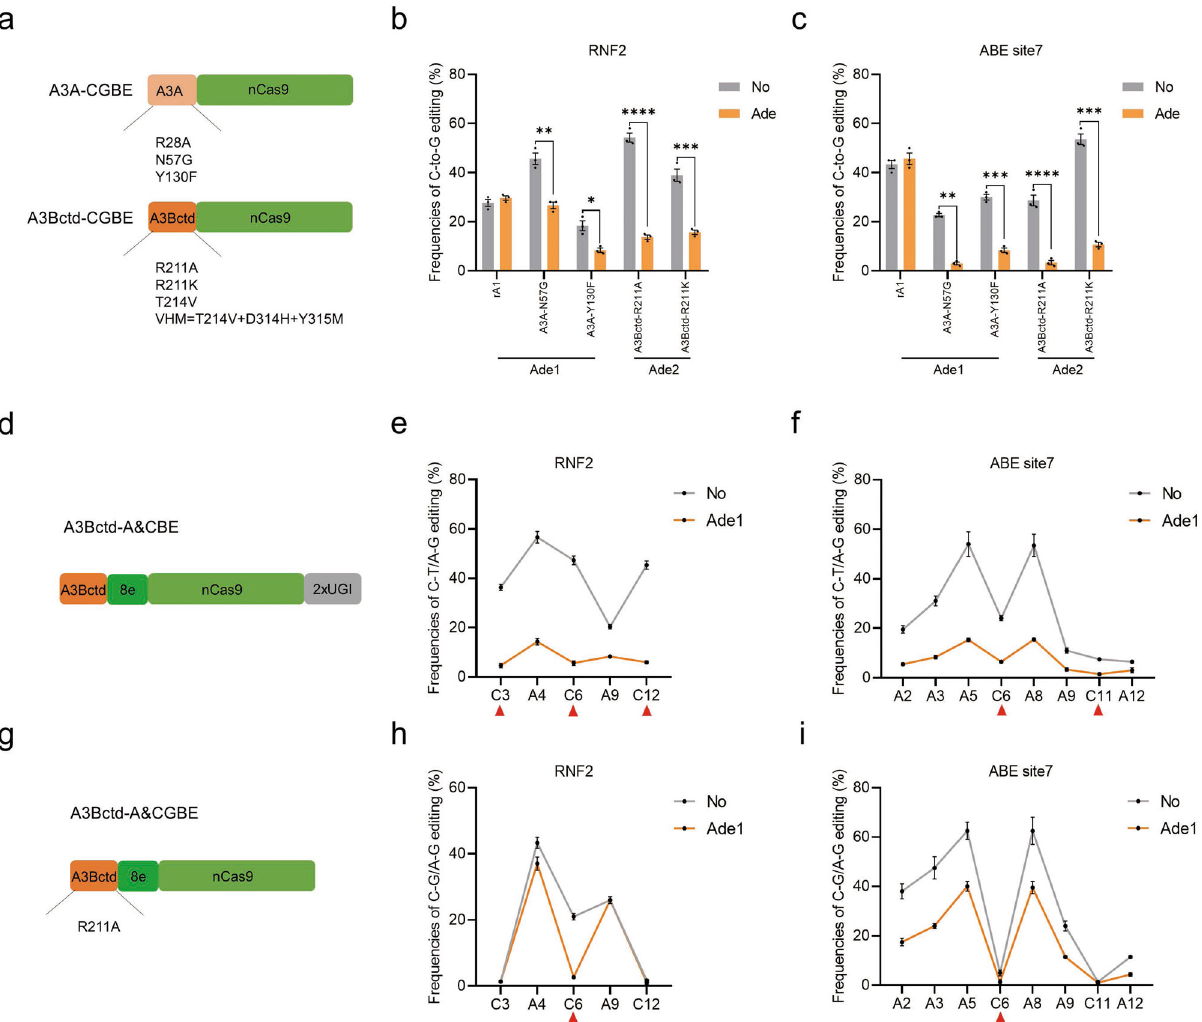
Fig. 3 Expanding the application of Ades to CGBE, A&CBE and A&CGBE. a Schematic representation of engineered A3A variant- and A3Bctd variant- CGBEs. nCas9, D10A. b Bar plots showing the base editing frequencies induced by rA1 variants, A3A variants-, and A3Bctd variants-CGBEs at the RNF2 site. Target C, red. c C-to-G editing frequencies of four representative CGBEs in the presence or absence of Ade at the RNF2 site. Plasmids expressing CGBE, sgRNA, and Ade (1:1:1) were cotransfected into HEK293T cells. d Schematic representation of engineered A3Bctd-A&CBE. nCas9, D10A. e , f Frequencies of single C-to-T and A-to-G conversions using A3Bctd-A&CBE in the presence or absence of Ade1 at RNF2 ( e ) and ABE site7 ( f ). Target C, red triangle. g Schematic representation of engineered A3Bctd-A&CGBE. nCas9, D10A. h , i Frequencies of single C-to-G and A-to-G conversions using A3Bctd-A&CGBE in the presence or absence of Ade1 at RNF2 ( h ) and ABE site7 ( i ). Target C, red triangle. Values and error bars re fl ect the mean ± s.e.m. and n = 3 biologically independent experiments. All p values were calculated by two-sided t tests. * p < 0.05, ** p < 0.01, *** p < 0.001, **** p < 0.0001. Source data are provided as a Source Data fi